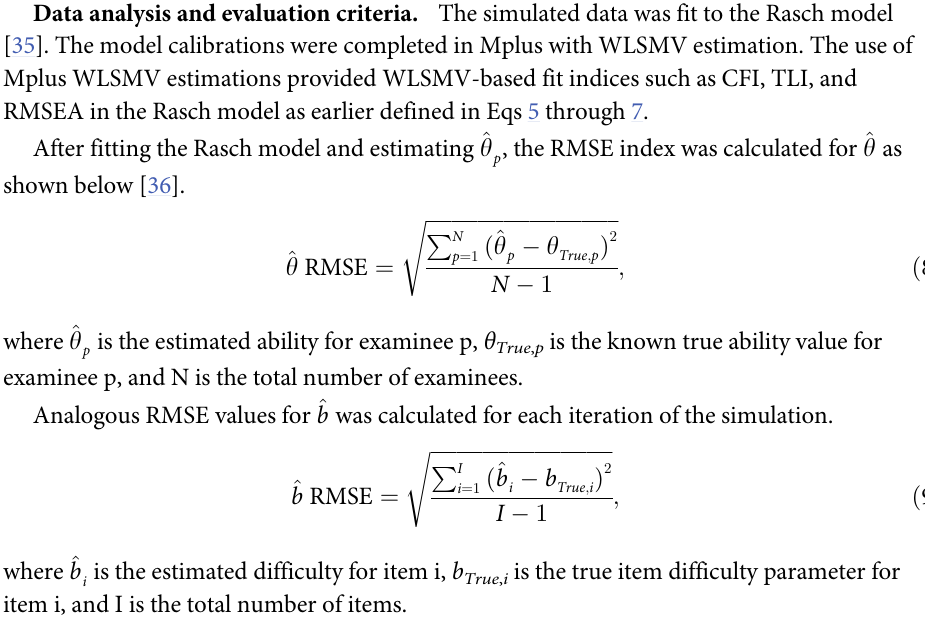
Table 1. Correlations between WLSMV-based fit indices and RMSE of parameter estimates.